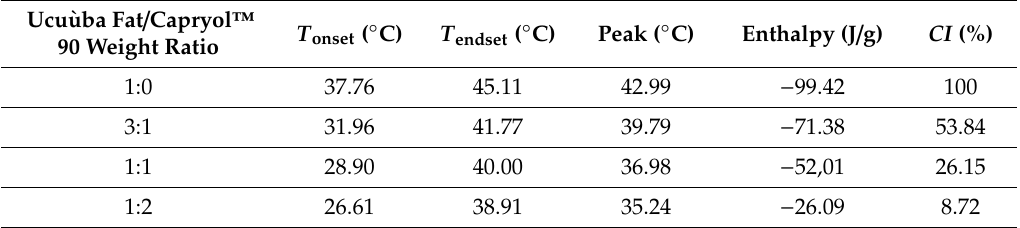
Table 6. Melting temperatures, enthalpy and crystallinity index ( CI ) obtained by DSC analysis of the Ucu ù ba fat alone and in mixture with Capryol ™